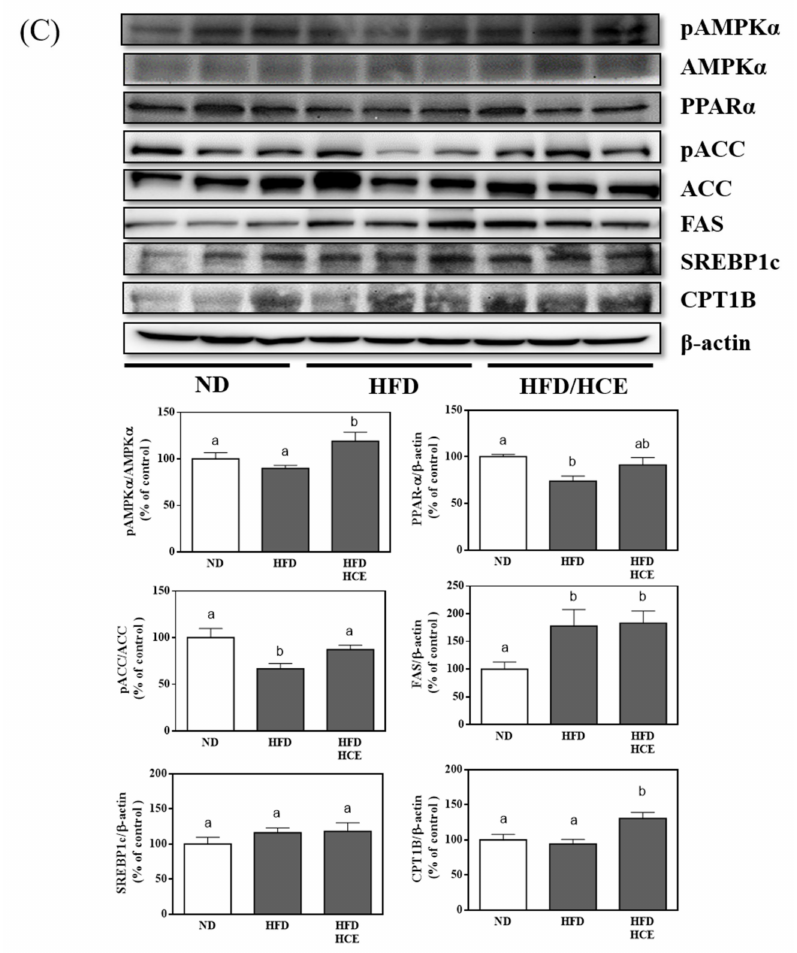
Figure 6. Effect of Djulis hull crude extract on the protein expression of ( A ) PPAR γ , IL-1 β , IL-6, and TNF- α , ( B ) SIRT1 and LXR α , and ( C ) lipogenesis and β -oxidation pathways in the livers of HFD-induced obese mice. ND: normal diet; HFD: high-fat diet; HCE: high dosage of crude extract. Values represent the mean ± SEM (n = 6). Statistical methods were used by one-way ANOVA, and the different letters are significantly different at p <